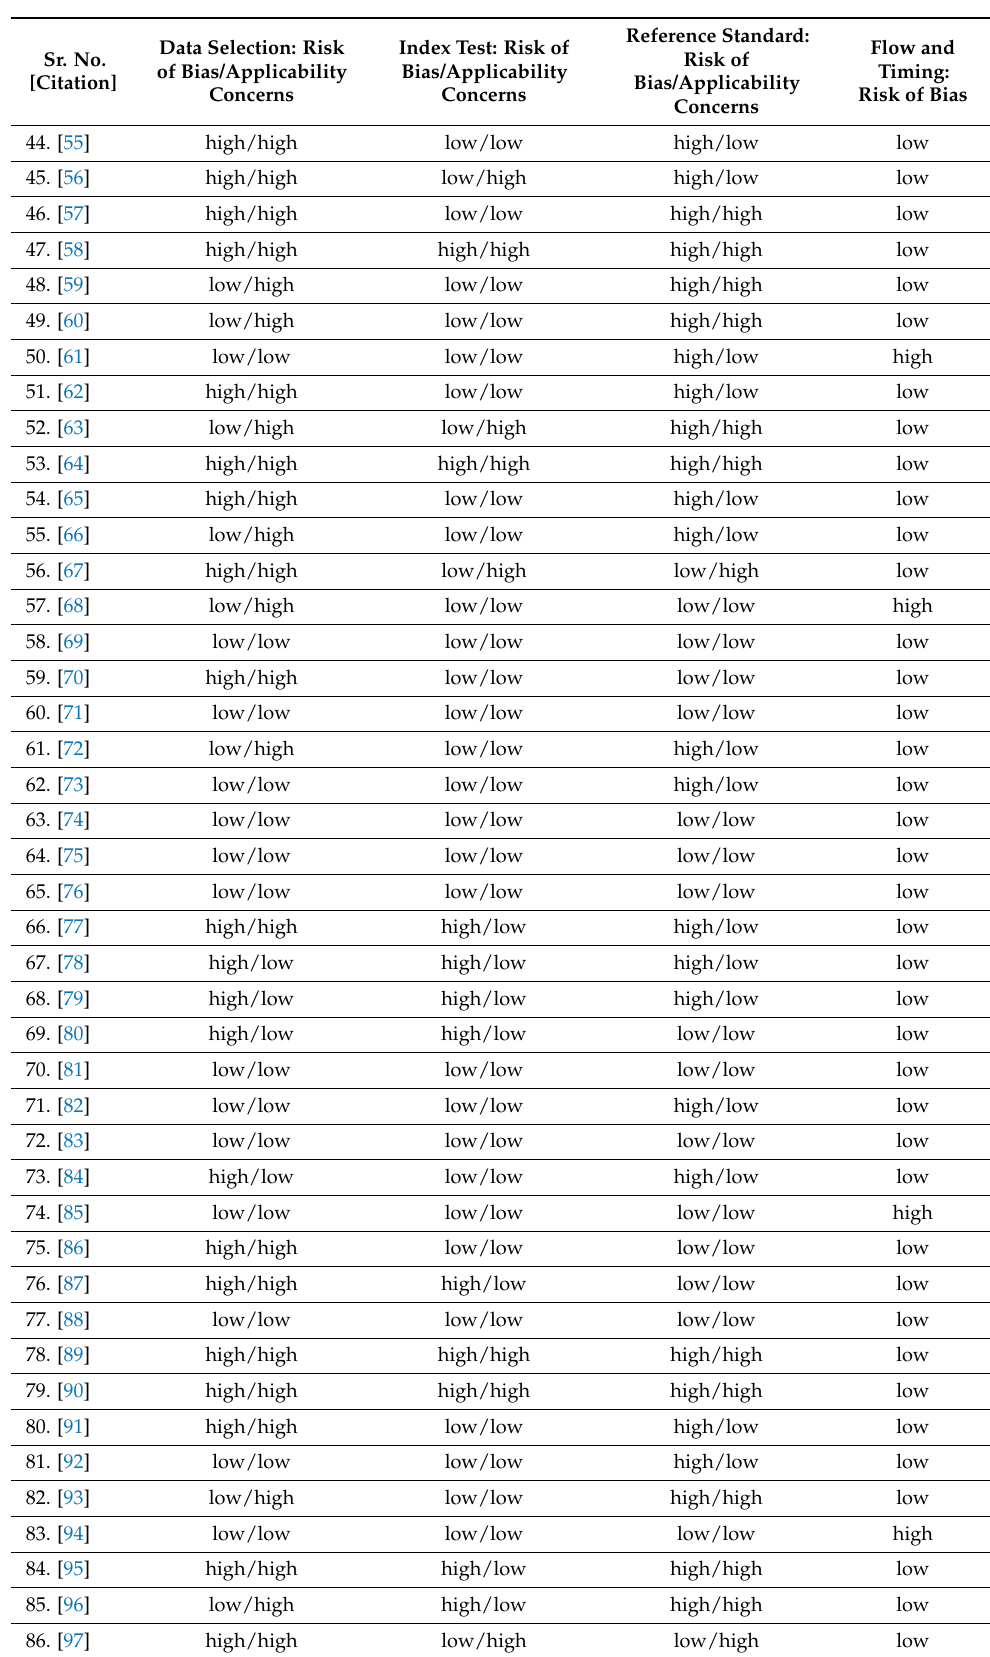
Table 1. Cont. Data Selection: Risk Sr. No. of [Citation]